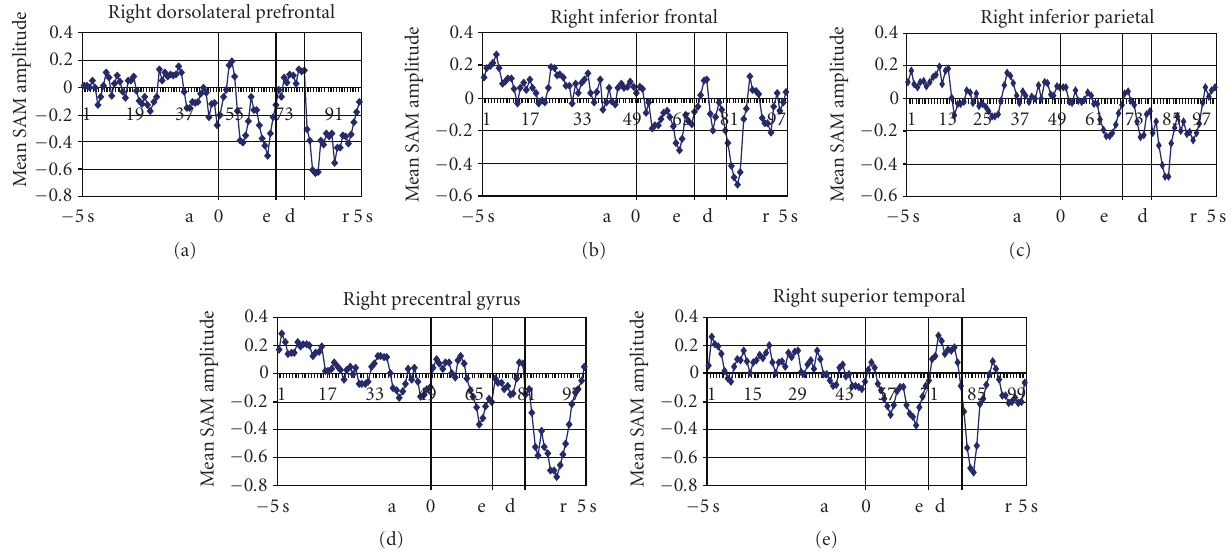
Figure 3: Time courses from each of the right hemisphere ROIs. a: anticipatory period; e: encoding period; d: delay; r: response period.